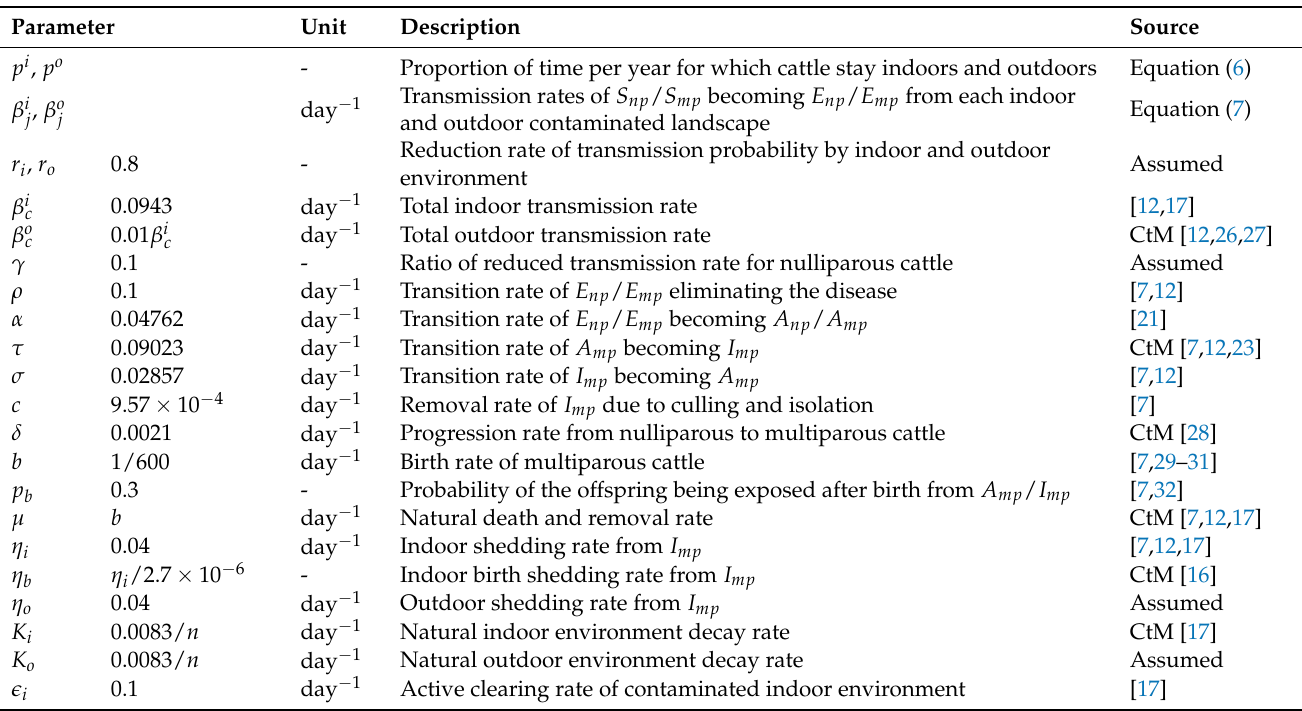
Table 1. The set of parameters and their description considered for the development of the model in Equations (2)–(5). CtM: Calibrated to